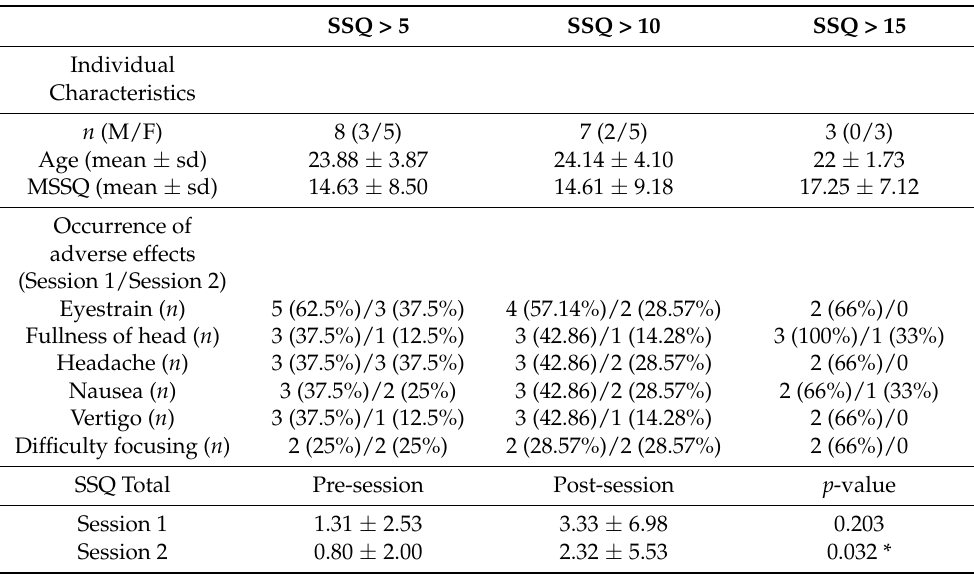
Table 1. Presentation of adverse effects by occurrence and SSQ total